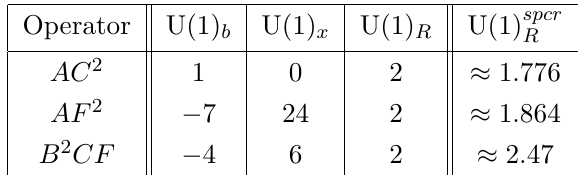
Table 2 . Possible superpotential terms with U(1) R charge 2. The last entry, U(1) spcr the approximate R-charge under the U(1) R symmetry expected to be the superconformal one in the IR when there is no